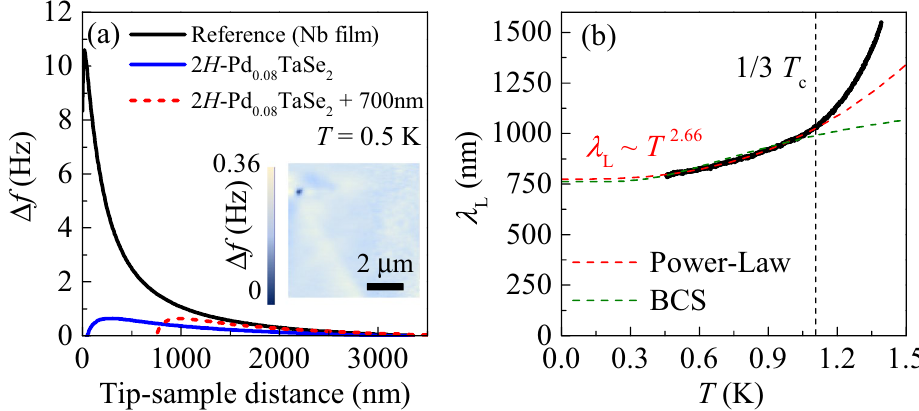
Figure 4. ( a ) Meissner force curves from the 2H-Pd 0.08 TaSe 2 single crystal at 0.5 K (blue solid line) and the reference sample (Nb, black solid line) to determine in-plane London penetration depth (cid:31) L . Using the comparative method (see the text), one can extract the absolute value of (cid:31) L . The addition of the shifted distance of 700 nm to the black solid line (red dashed line) leads to (cid:31) L ( 0.5 K ) 810 nm. Inset : MFM image obtained at T = 0.5 K. ( b ) Temperature dependence of the (cid:31) L . Below 1 3 T c , (cid:31) L ( T ) is fitted to both the single-band BCS formula (green dashed line) and the power-law ( AT former fails to reproduce the data while the latter fits better the data with the exponent n about 2.66, constituting compelling evidence on nodeless, multiband nature of the superconducting